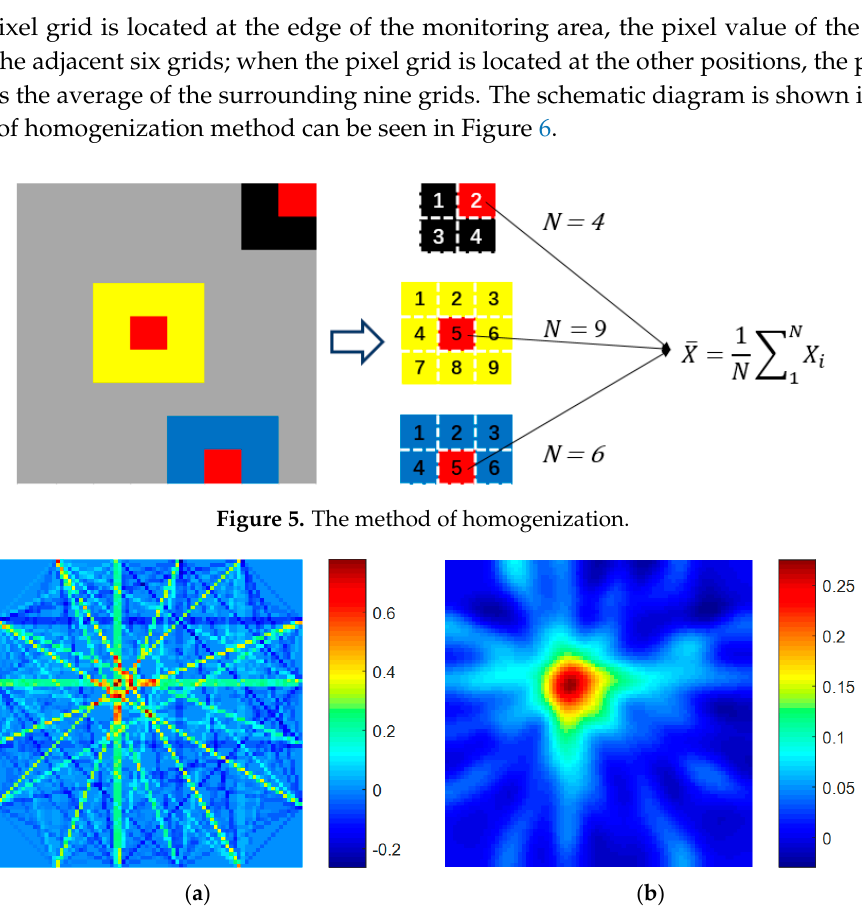
Figure 6. The imaging results ( a ) without homogenization and ( b ) with homogenization.